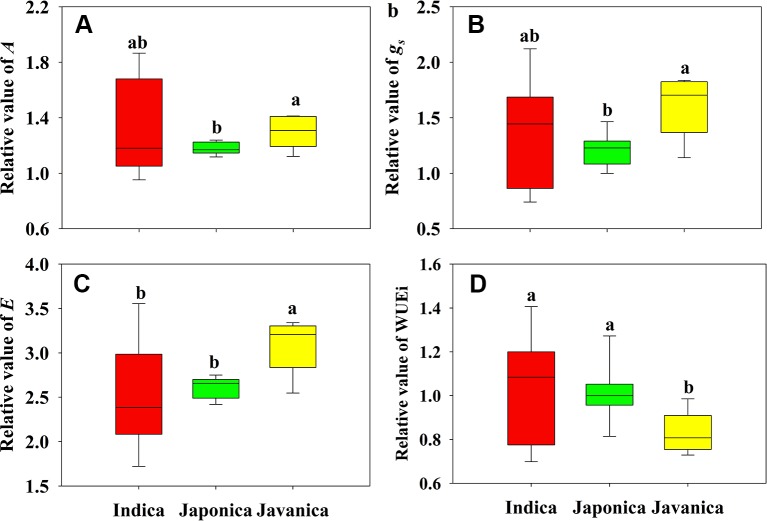
Relative value (HT/CK) of light saturated photosynthetic rate (A, A), stomatal conductance (gs, B), and transpiration rate (E, C), and intrinsic water use efficiency (WUEi, D) for the three rice (Oryza sativa L.) subspecies. Different lowercase letters indicate significant differences between subspecies means (p < 0.05). The outer box edges represent the 25th and 75th percentiles, the error bars are the 5th and 95th percentiles, and the line within the box represents the mean values. For each cultivar, three flag leaves were measured (one leaf per plant), and the three values were averaged as one biological replicate. n (the biological replicates) was 8, 8, and 5 for the indica, japonica, and javanica cultivars, respectively.